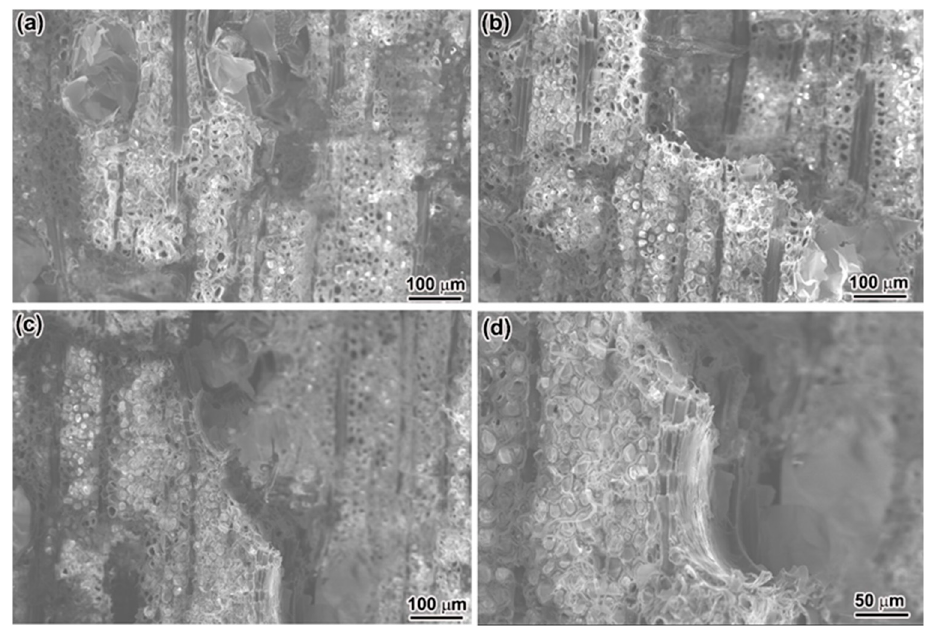
Figure 6. SEM images of fractured vessels ( a , b ), cracks propagate from one vessel to the adjacent vessel ( c ), and the magnified images of one fractured vessel ( d ) in failed BW samples. The tensile strength is arranged from 51.0 to 120.7 MPa for hardwood and from 45.4– 117.7 MPa for softwood, and the fracture toughness of wood is arranged from 2.05 to 5.17